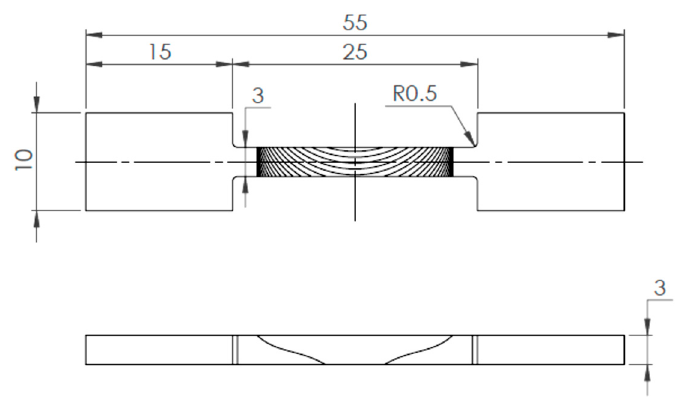
Figure 2. Drawing of a tensile